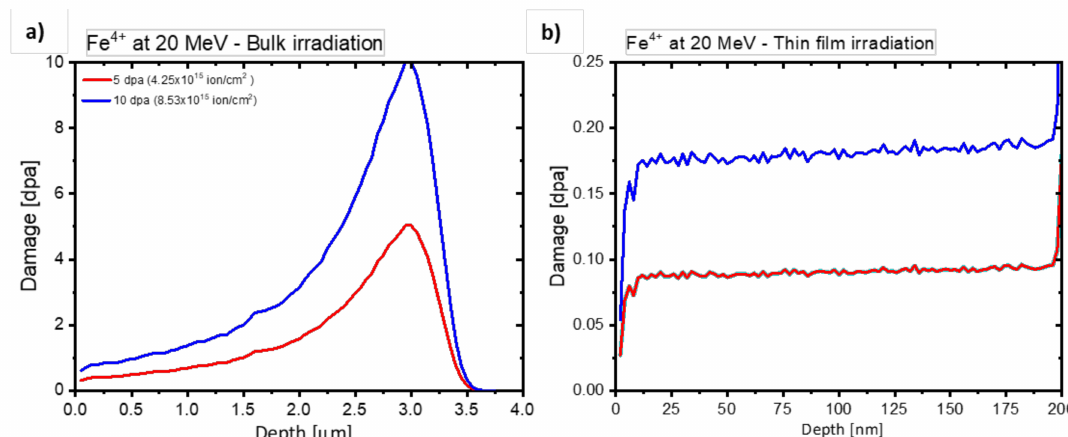
Figure 3. Damage profile for the fluences used in the experiments: low dose (LD), 4.25 × 10 15 ion/cm 2 , and high dose (HD), 8.53 × 10 15 ion/cm 2 , which correspond to the damage level at the peak of 5 and 10 dpa, respectively, ( a ), and the damage expected only in the first 200 nm for the same fluences, ( b